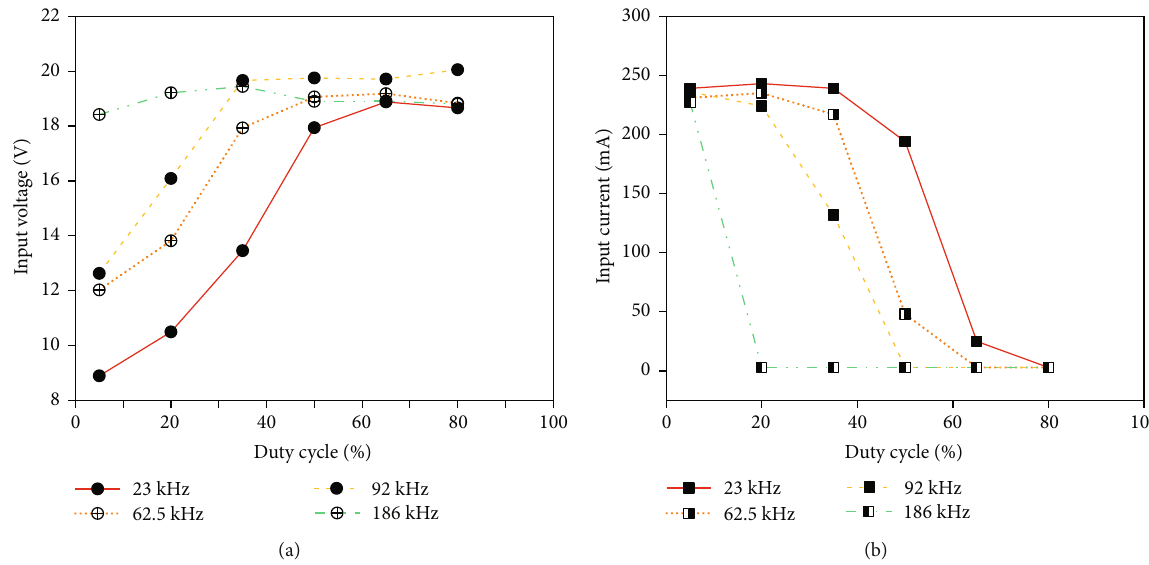
Figure 13: Power test result of the designed buck converter circuit using a halogen lamp: (a) input voltage vs. duty cycle; (b) input current vs. duty cycle.